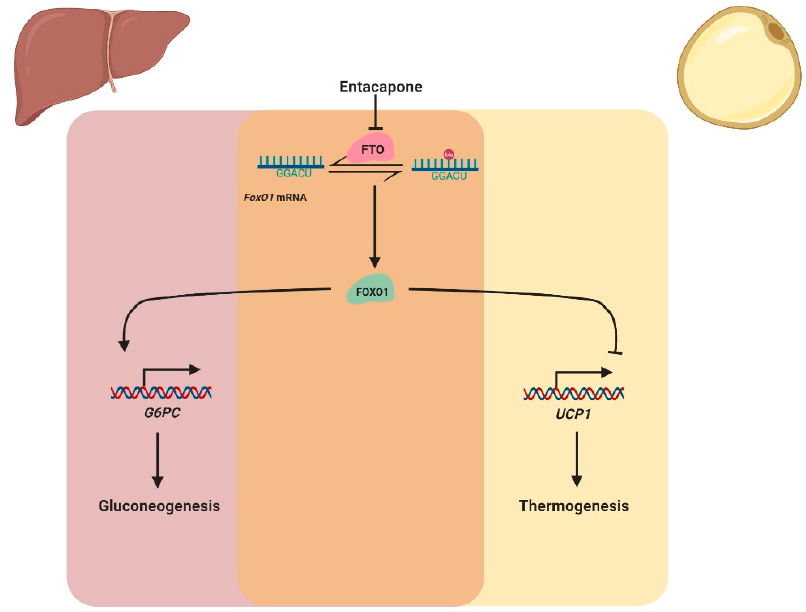
Figure 6. Entacapone suppresses gluconeogenesis in the liver and increases thermogenesis in adipocytes through reducing FOXO1 expression (created with BioRender.com).